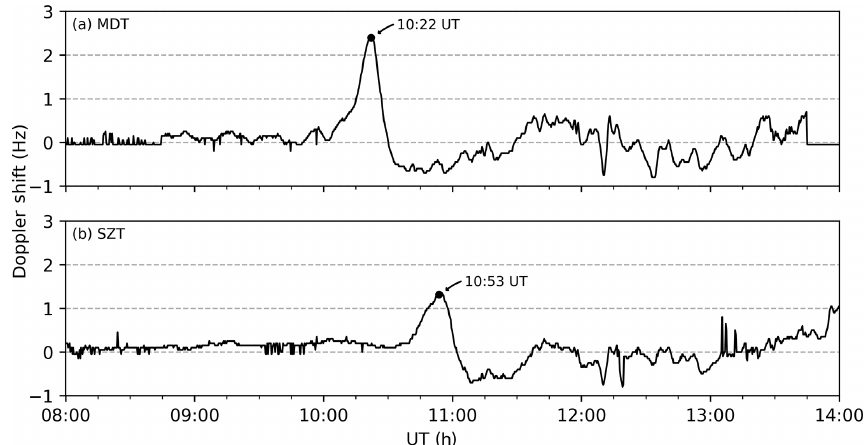
Figure 3. Temporal variations in the HF Doppler shift records from (a) MDT and (b) SZT between 08:00 and 14:00UT, 17 March